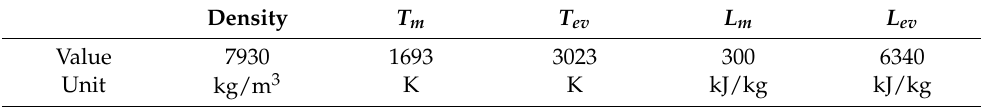
Table 1. The fixed physical parameters of stainless steel 304 [27].